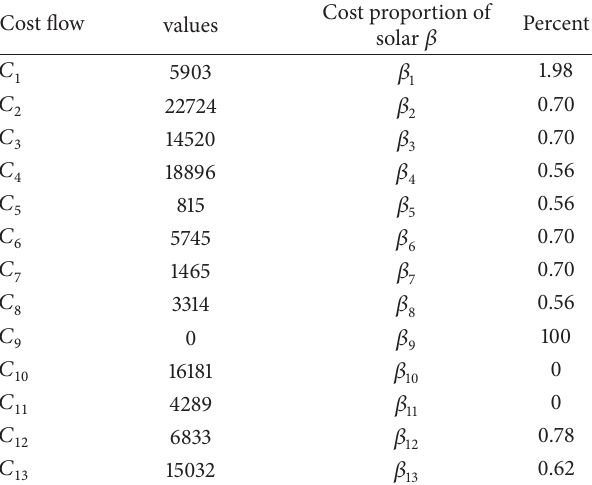
Table 6: Exergy cost of each flow and the proportion of solar